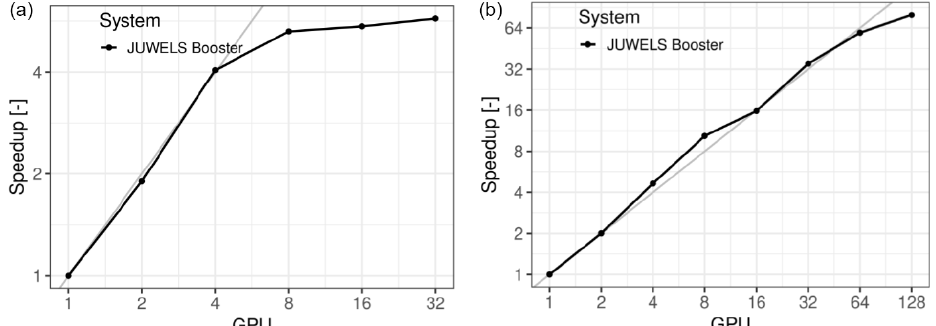
Figure 17. Strong scaling behaviour for a circular dam break test case with two resolutions. (a) δx = 0.05, 64 million cells. (b) δx = 0.025, 256 million cells.